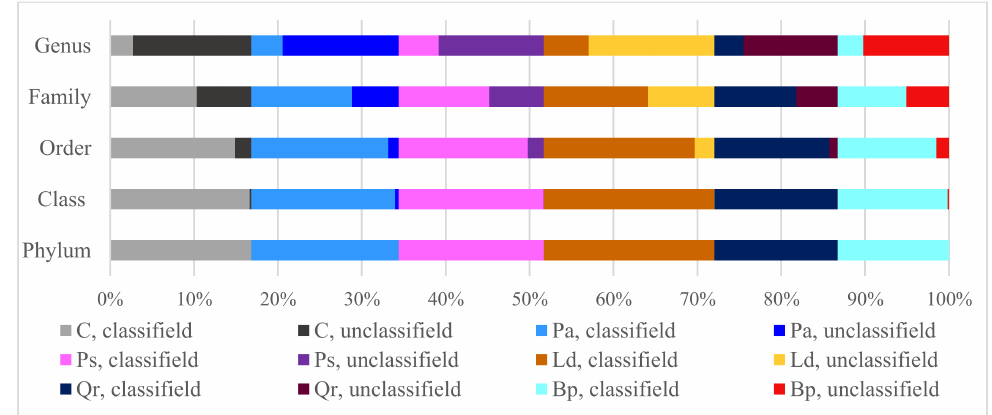
Figure 2. The total number of OTU. C—non-afforested land, Pa— Picea abies L., Ps— Pinus sylvestris L., Ld— Larix decidua M., Qr— Quercus robur L., and Bp— Betula pendula